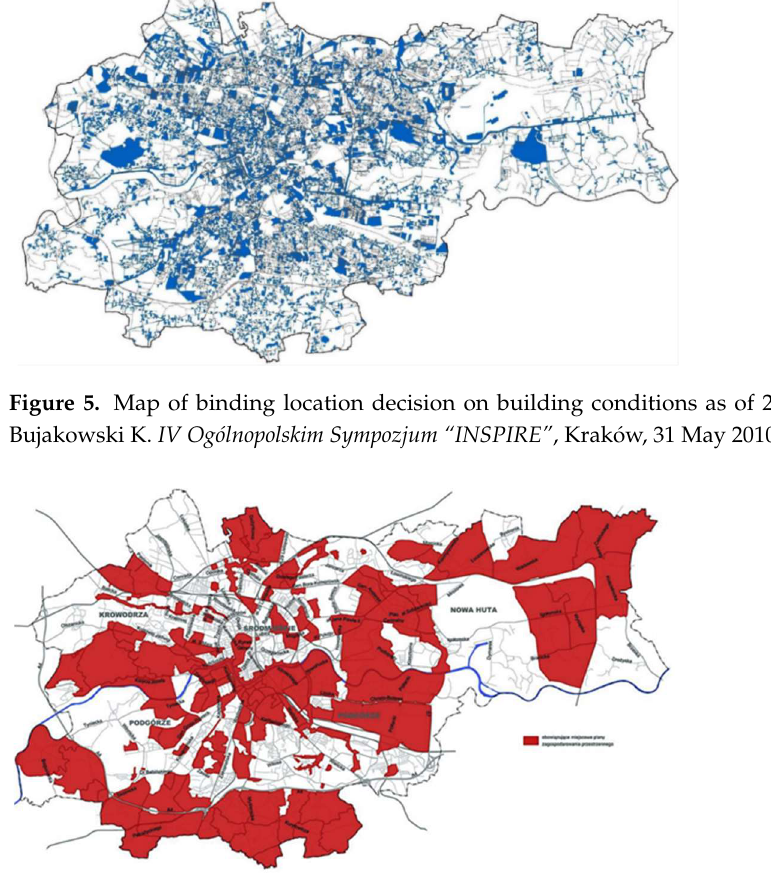
Figure 7. Map of binding sub-local zoning plans (red color) as of 2021. Source: Krakow City Coun- cil, https://www.bip.krakow.pl/?dok_id=119734 (accessed on 20 July 2021). The greatest impact on the justification of the author’s thesis, apart from the first guidelines of J.M. Chmielewski [4,5] about the German land use plan, was exerted by the publication of A. Tölle [6], which perfectly explains what integrated forms of planning and managing local development are in the context of the selection of appropriate plan- ning studies by comparing the Polish system to the German system. 3. Material and Methods In an interdisciplinary approach to the topic, the author uses her extensive profes- sional experience, including as the author of many architectural and urban projects, plan- ning acts, and work as a construction supervision expert at the Main Office of Construc- tion Supervision 2000–2010, as well as in a local government unit (implementing the Ge- ographical Information System for the needs of the City Hall Warsaw). The qualitative research consists of an analytical and an empirical part. For the purposes of the research, it was assumed that spatial planning is a special case of management and not an activity undertaken during management. Such an as- sumption is even more justified as the new approach to strategic development planning requires its integration with spatial planning and presenting the spatial management of a given territory in a more holistic manner. In the thesis, in this sense, the term ‘spatial man- agement’ was used, which refers to local, subregional, and regional spatial planning. In the first stage of the research, in 2011–2013, in literature on the subject, the INSPIRE technical guidelines were analyzed; interviews with INSPIRE experts (Prof. Z. Parzyński, Prof. D. Dukaczewski, and Prof. A. Głażewki) and land use and spatial planning experts